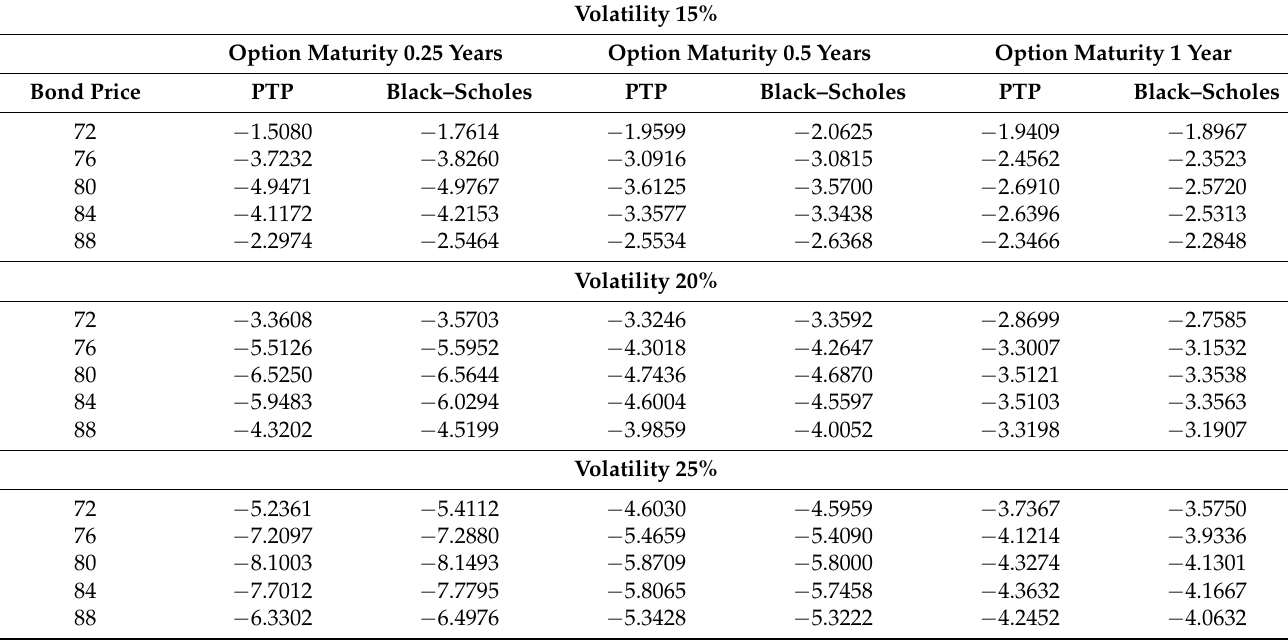
Table 5. Comparison of PTP thetas to Black–Scholes: strike price 80, risk-free rate 0.5%, bond maturity 20 years.